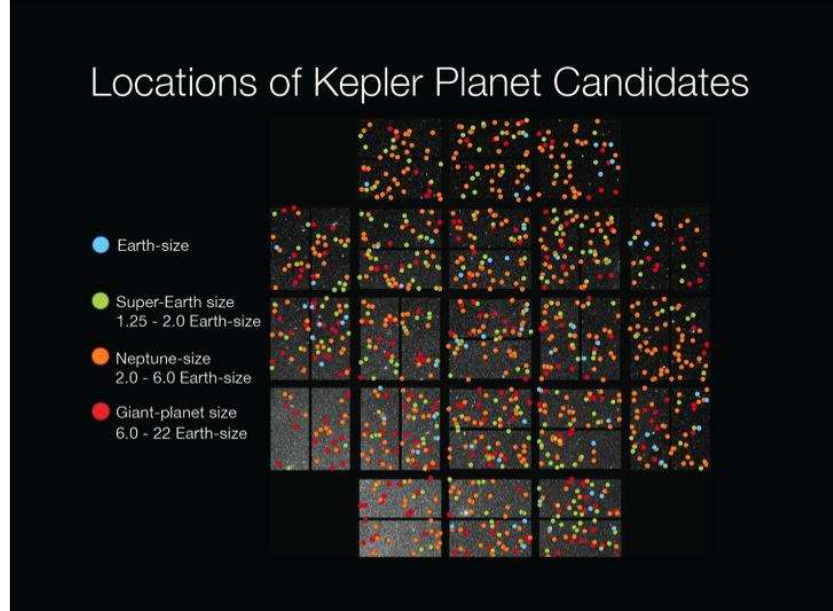
Figure 1. The location of Kepler planet candidates known by 7 August 2017 is shown for the wide field observed in the constellations of Cygnus and Lyra during the main nominal mission (about four years). Image credit: NASA/Wendy Stenzel.